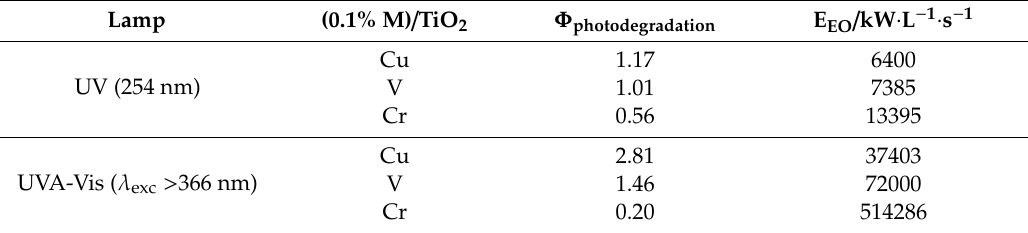
Table 6. Photodegradation quantum yields ( Φ photodegradation) and energy e ffi ciency (E EO ) for the photocatalyzed degradation of phenol over (0.1% M) / TiO 2 composites under Vis ( λ exc > 366 nm)